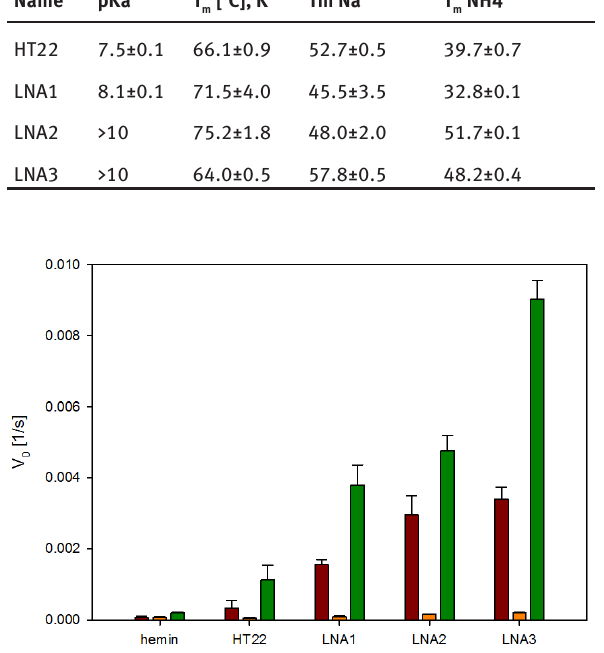
) and hemin protonation constants m